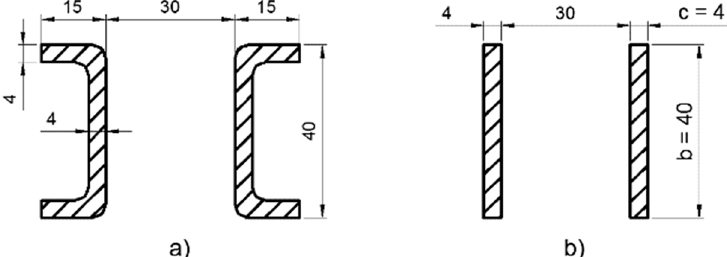
Figure 5. Cross-section of the earthing knife of one phase: ( a ) type RGB 38-25, ( b ) subject of this paper; (dimensions are in mm).